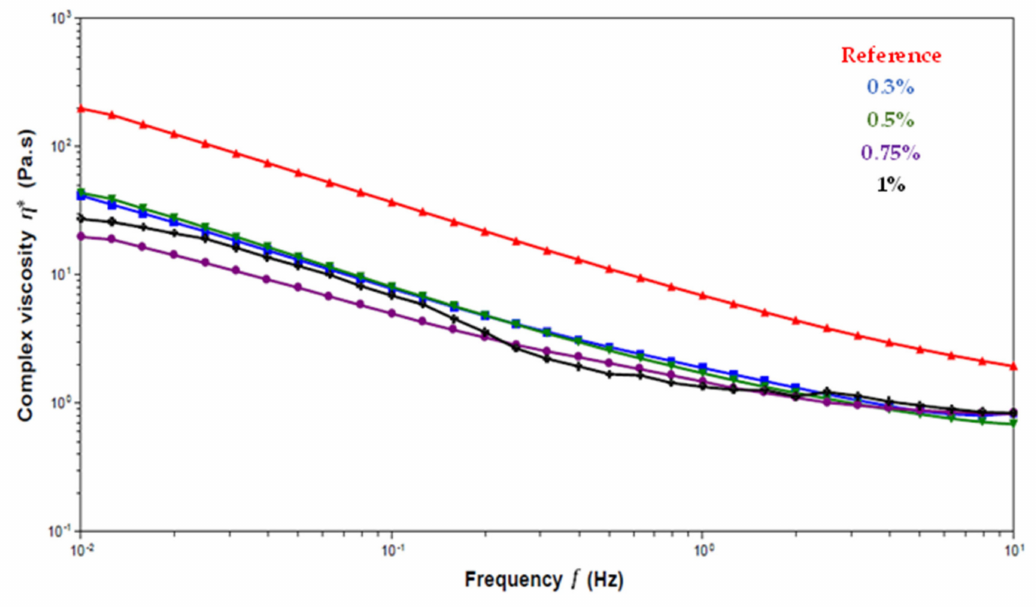
Figure 6. Complex viscosities of PGE with different loads of WS 2 -C at room temperature.